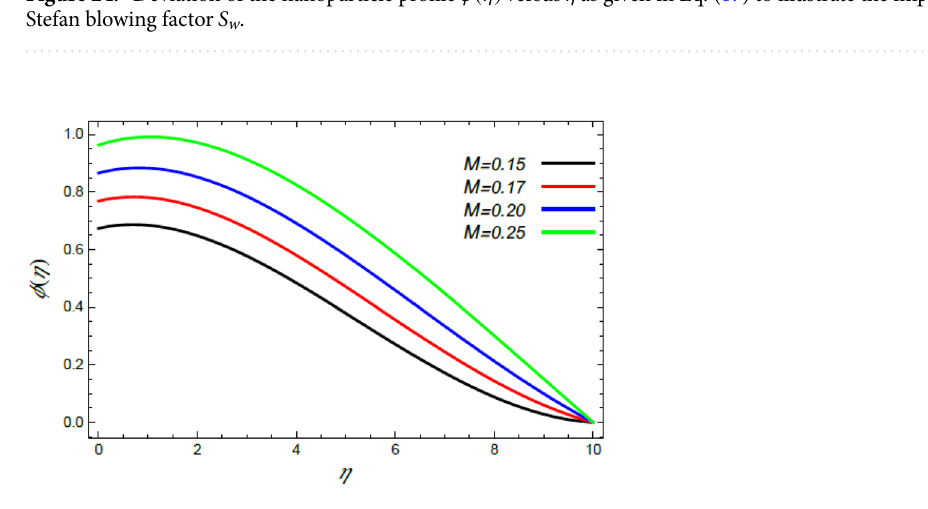
Figure 25. Deviation of the nanoparticle profile ϕ(η) versus η as given in Eq. (67) to illustrate the impact of the magnetic parameter M .